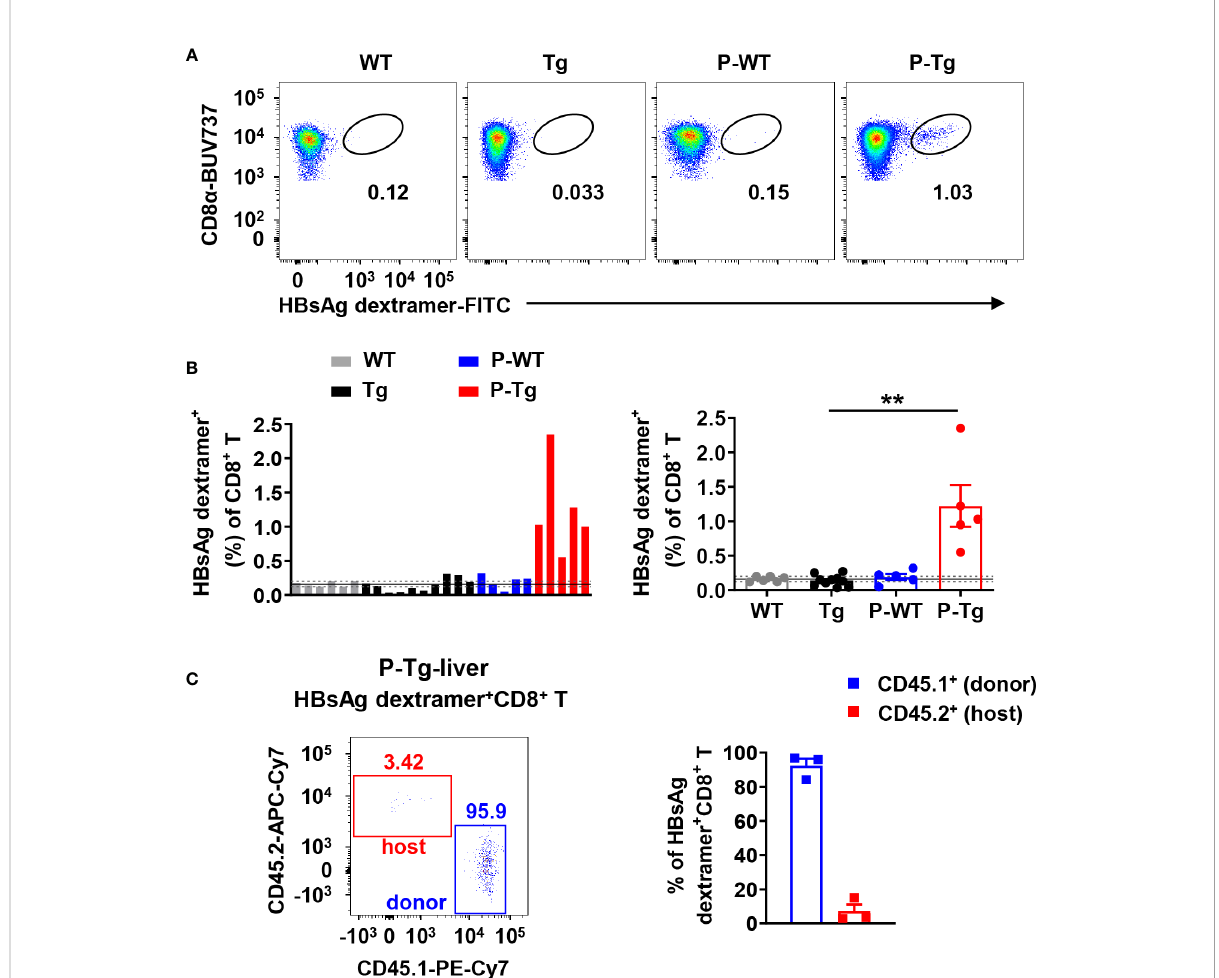
FIGURE 3 Intrahepatic HBsAg-speci fi c CD8 + T cells in HBs-Tg parabionts were derived from donor WT mice but not host HBs-Tg mice. HBs-Tg mice (CD45.2 + ) were conjoined with WT mice (CD45.1 + ) to generate WT-HBs-Tg parabiotic mice. Four weeks after parabiosis surgery, parabiotic mice were separated and liver samples were harvested from each group. Intrahepatic MNCs were isolated for fl ow cytometry analysis. (A) Representative plots showing the frequency of H-2 kb -HBsAg VWLSVIWM dextramer + CD8 + T cells in the liver of each group. CD8 + T cells (CD45 + CD3 + NK1.1 - CD8 + ) were gated to analyze the HBsAg-speci fi c CD8 + T cells by using MHC dextramer staining. (B) The frequency of H- 2 kb -HBsAg VWLSVIWM dextramer + CD8 + T cells in each sample was shown. According to the data of the control WT group (negative control), the mean value (black line, 0.16%) and 95% con fi dence interval (CI) (gray dotted line, 0.16% ± 0.04%, n=6) were obtained, indicating that the data of the frequency of HBsAg dextramer + CD8 + T cells (> 0.20%) were considered statistically positive. Statistical analysis of the frequency of HBsAg dextramer + CD8 + T cells in the liver of P-Tg compared with the control. (C) The proportion of CD45.1 + (donor) or CD45.2 + (host) in HBsAg dextramer + CD8 + T cells in the liver of P-Tg. Data are shown as mean ± SEM. A Fisher ’ s exact test was used (B) . ** P < 0.01. WT, WT control; Tg, HBs-Tg control; P-WT, WT parabiont; P-Tg, HBs-Tg